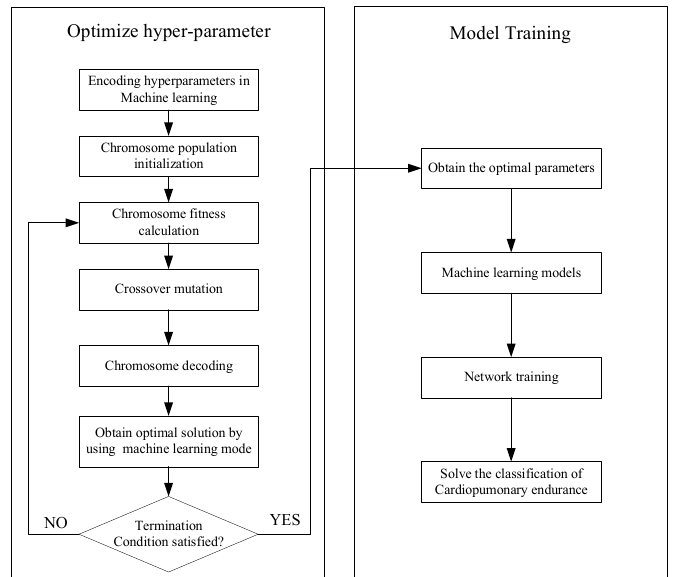
Figure 4. Optimization Flow Chart of Genetic Algorithm.